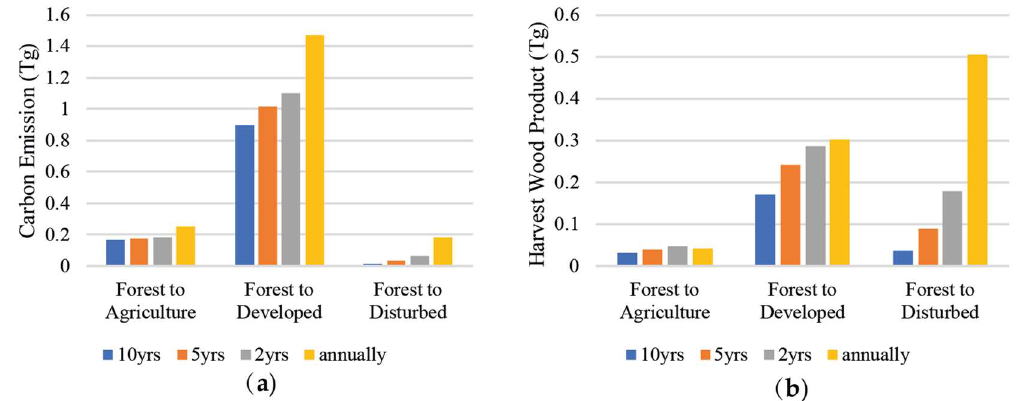
Figure 10. Comparison of carbon emissions ( a ) and harvest wood products ( b ) resulting from LULCC with time density and data source.